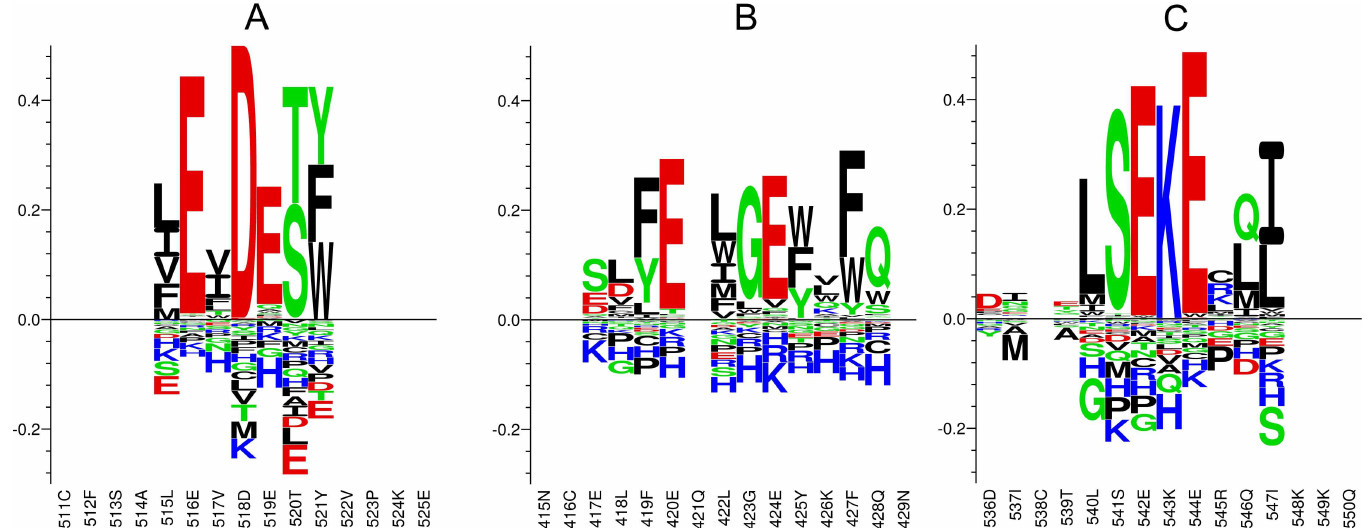
Fig 5. Examples of selectivity profile of epitope. Logo-plotrepresentations of the selectivity of three 15-residueregions of the primary sequenceof HSA. Selectivity is determined by Dunnett’s test on all substitutionsof target position,being representedin overlappingpeptides. Each letter represents replacing amino acids and is scaled by log( p ),where the p-value is obtained from the Dunnett’stest. Positive letters denotes substitution values abovethe globalmean, μ g , while negativeletters denotessubstitutionvalues below μ g . The absolute heightof an entire column represents the averagerelative changein signal of all substitutionsof target residue. The averagesignal of native 15-mer peptidescontainingthe epitopes is ( A ) 489 Au, ( B ) 130 Au and ( C ) 176 Au.